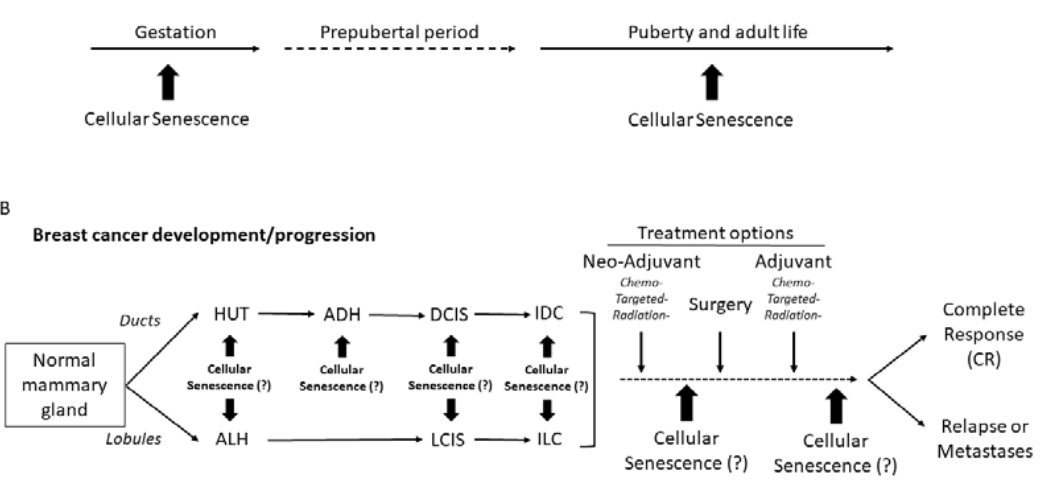
Figure 2. Graphic timeline of events in normal mammary-gland development ( A ) and breast-cancer (IDC and ILC) initiation, progression, and treatment ( B ), depicting the possible stages where cellular senescence may play a significant role in vivo. Question marks (?) indicate stages of possible cellular senescence involvement, with ambiguous effects on carcinogenesis and response to treatment. ADH: atypical ductal hyperplasia; ALH: atypical lobular hyperplasia; DCIS: ductal carcinoma in situ; HUT: hyperplasia of usual type; IDC: invasive ductal carcinoma; ILC: invasive lobular carcinoma; LCIS: lobular carcinoma in situ.